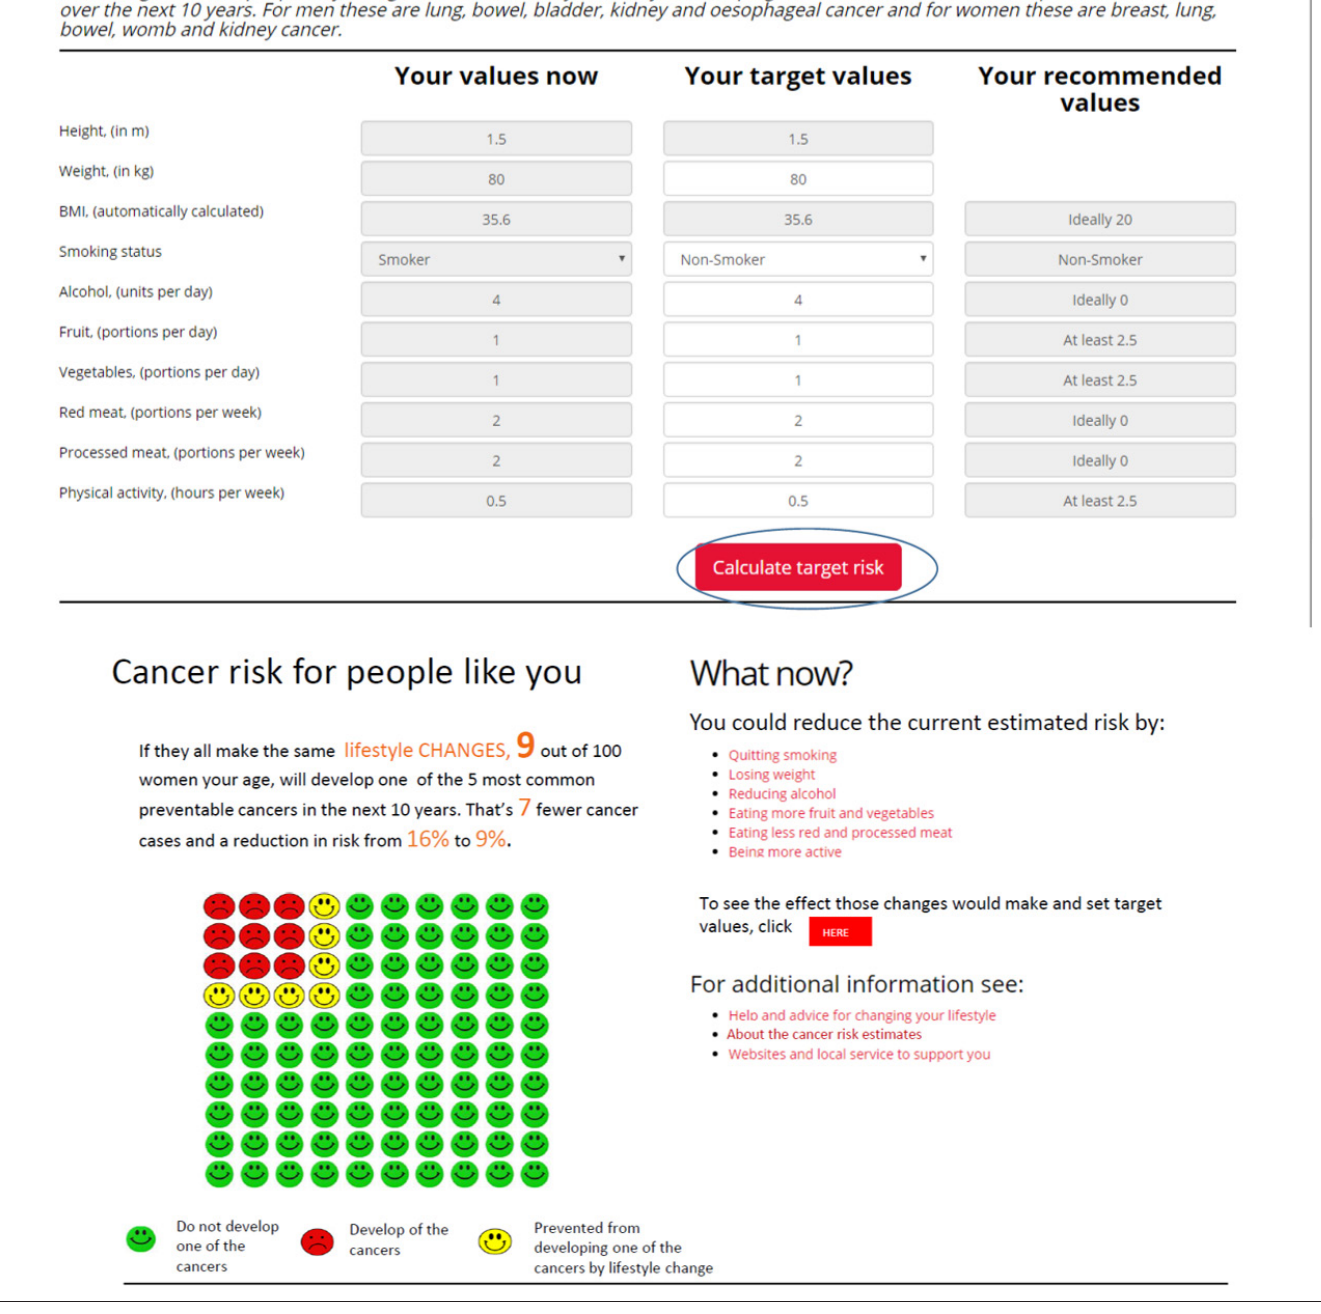
Figure 1 Screenshots of cancer risk tool